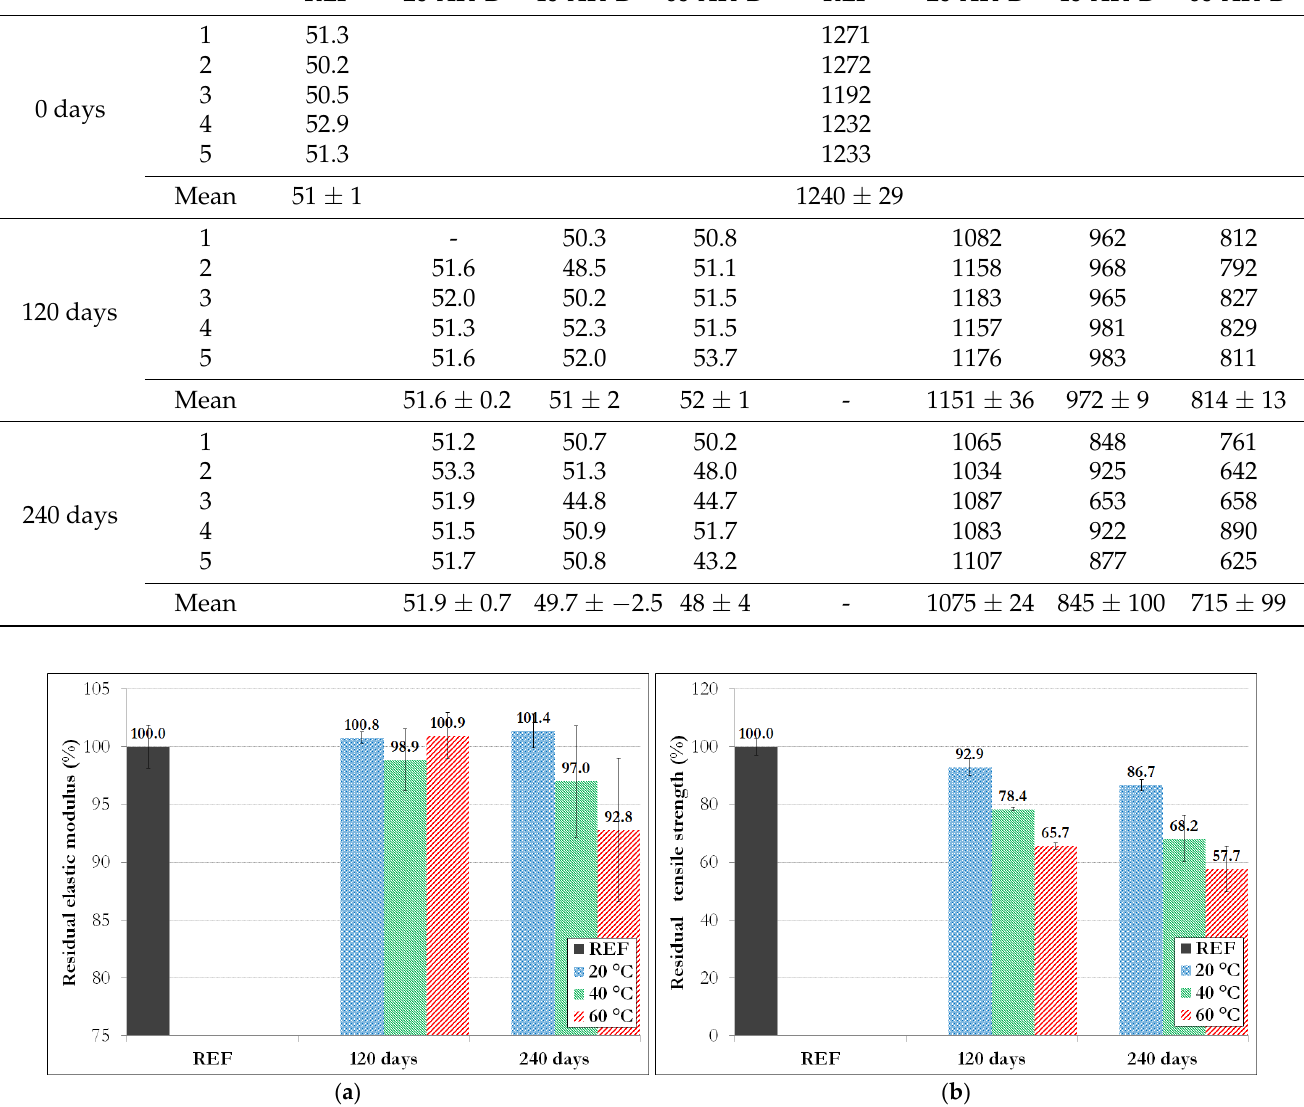
Figure 13. Residual tensile properties of GFRP rebars subjected to direct immersion in the alkaline: ( a ) elastic modulus and ( b ) tensile